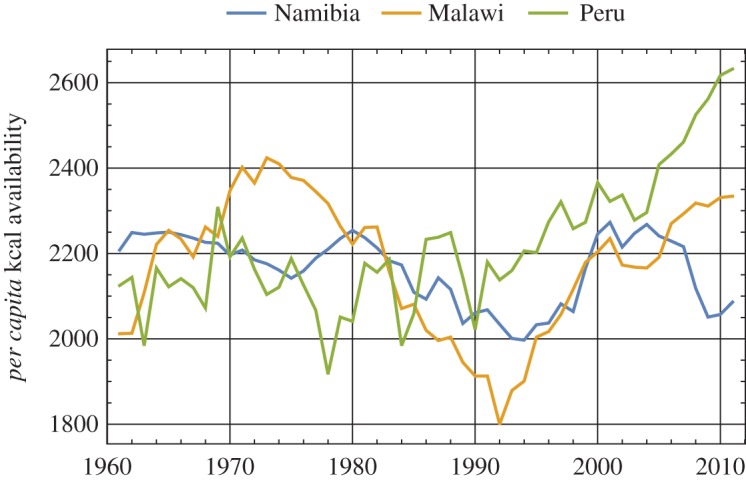
Illustration of resilience and resistance with respect to per capita kilocalorie availability with the examples of Namibia, Malawi and Peru between 1961 and 2011. Namibia exhibits a slightly declining long-term trend and high persistence of the effects of shocks; neither of the criteria for resilience is met. By contrast, the trend is neutral to positive for the Malawi and Peru cases. Malawi exhibits strong persistence throughout the time series. Slopes of time increments tend to be autocorrelated—rising for a decade, falling for two decades, and then rising again—and so the country is not considered resilient. The Peru series, unlike the other two countries, is very anti-persistent. The anti-persistence is seen in the relatively rapid reversals of slope; the effects of shocks do not last. Because the Peru series is both upward trending and anti-persistent, we label it resilient. All three countries, however, are volatile, and so not resistant.